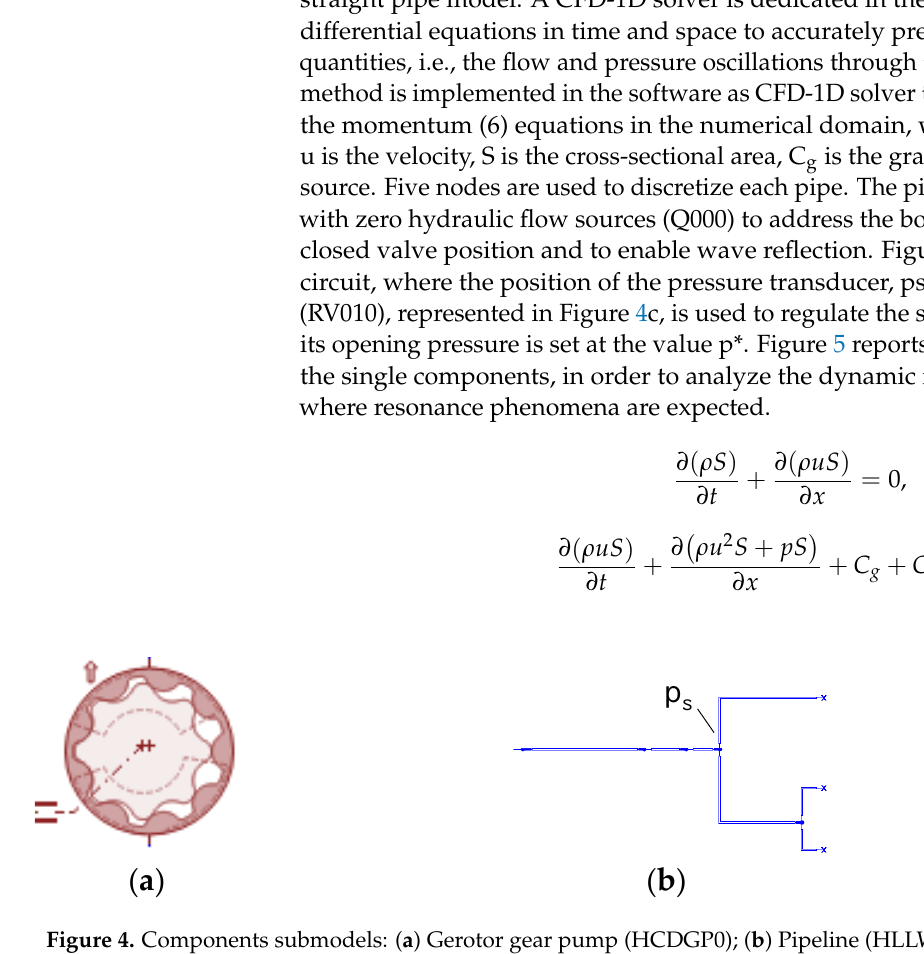
Energies 2021 , 14 , x FOR PEER REVIEW